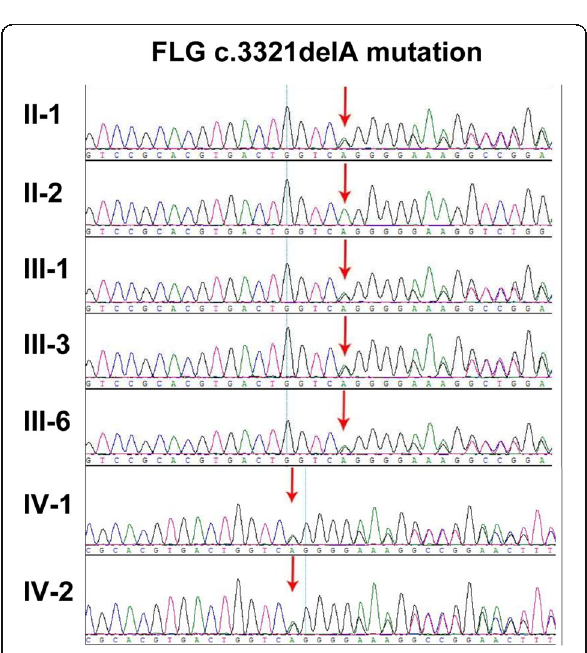
Fig. 4 FLG c.3321delA mutation in a Chinese family with